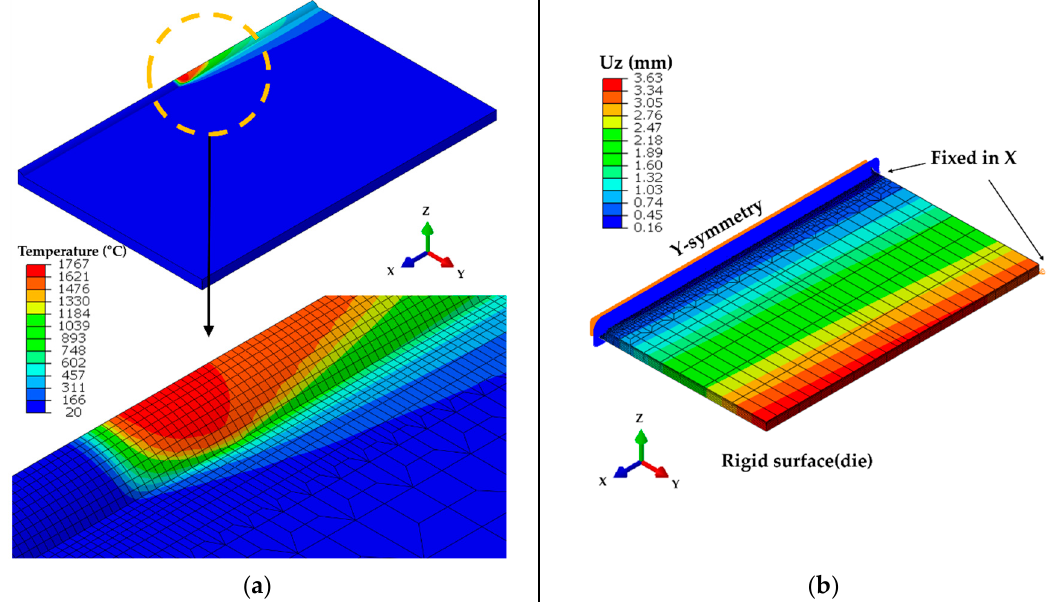
Figure 7. FEM analysis model: ( a ) Analysis of heat transfer under a moving heat source; ( b ) Boundary condition for thermal elastoplastic analysis.